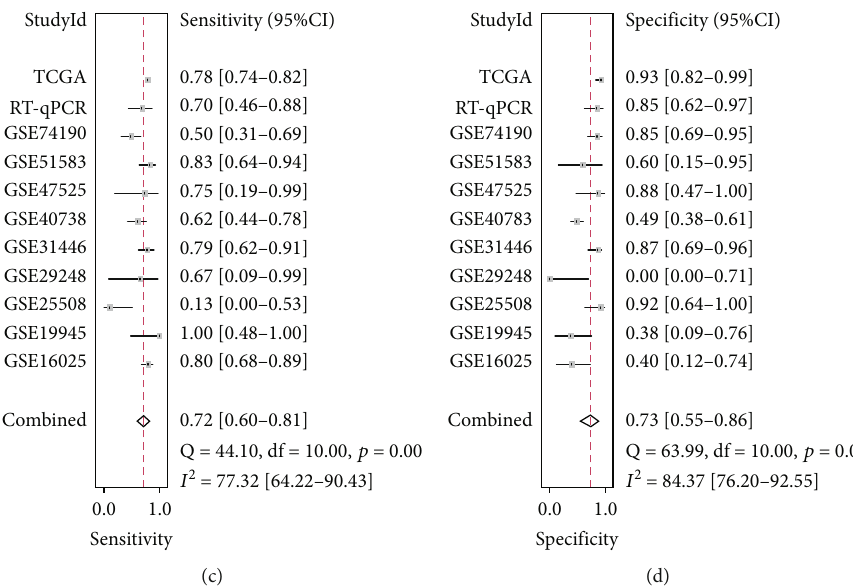
Figure 5: Integrated analysis of the miRNA-33a-5p expression value obtained from RT-qPCR, TCGA dataset, and public miRNA microarrays. (a) Forest plot of SMD to validate the high expression of miRNA-33a-5p in LUSC. (b) The SROC curve of miRNA-33a-5p in the diagnosis ability of LUSC data from all involved datasets ( AUC = 0 : 78 , 95% CI: 0.74-0.82). (c) The forest plot of sensitivity; (d) The forest plot of speci fi city. P < 0 : 05 indicates a statistically signi fi cant di ff erence. SMD: standard mean di ff erence; TCGA: The Cancer Genome Atlas; CI: con fi dence interval; SROC: summary receiver operating characteristic; AUC: area under the curve; RT-qPCR: quantitative real-time